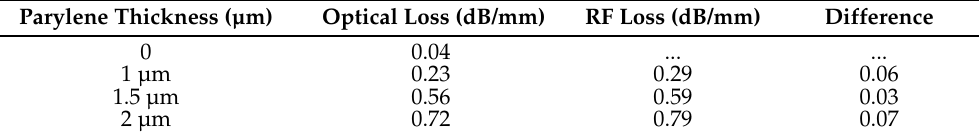
Table 2. Comparison of optical and RF loss measurements as functions of parylene thickness. Parylene Thickness (µm) Optical Loss (dB/mm) RF Loss (dB/mm) Difference 0 0.04 ... ... 1 µm 0.23 0.29 0.06 1.5 µm 0.56 0.59 0.03 2 µm 0.72 0.79